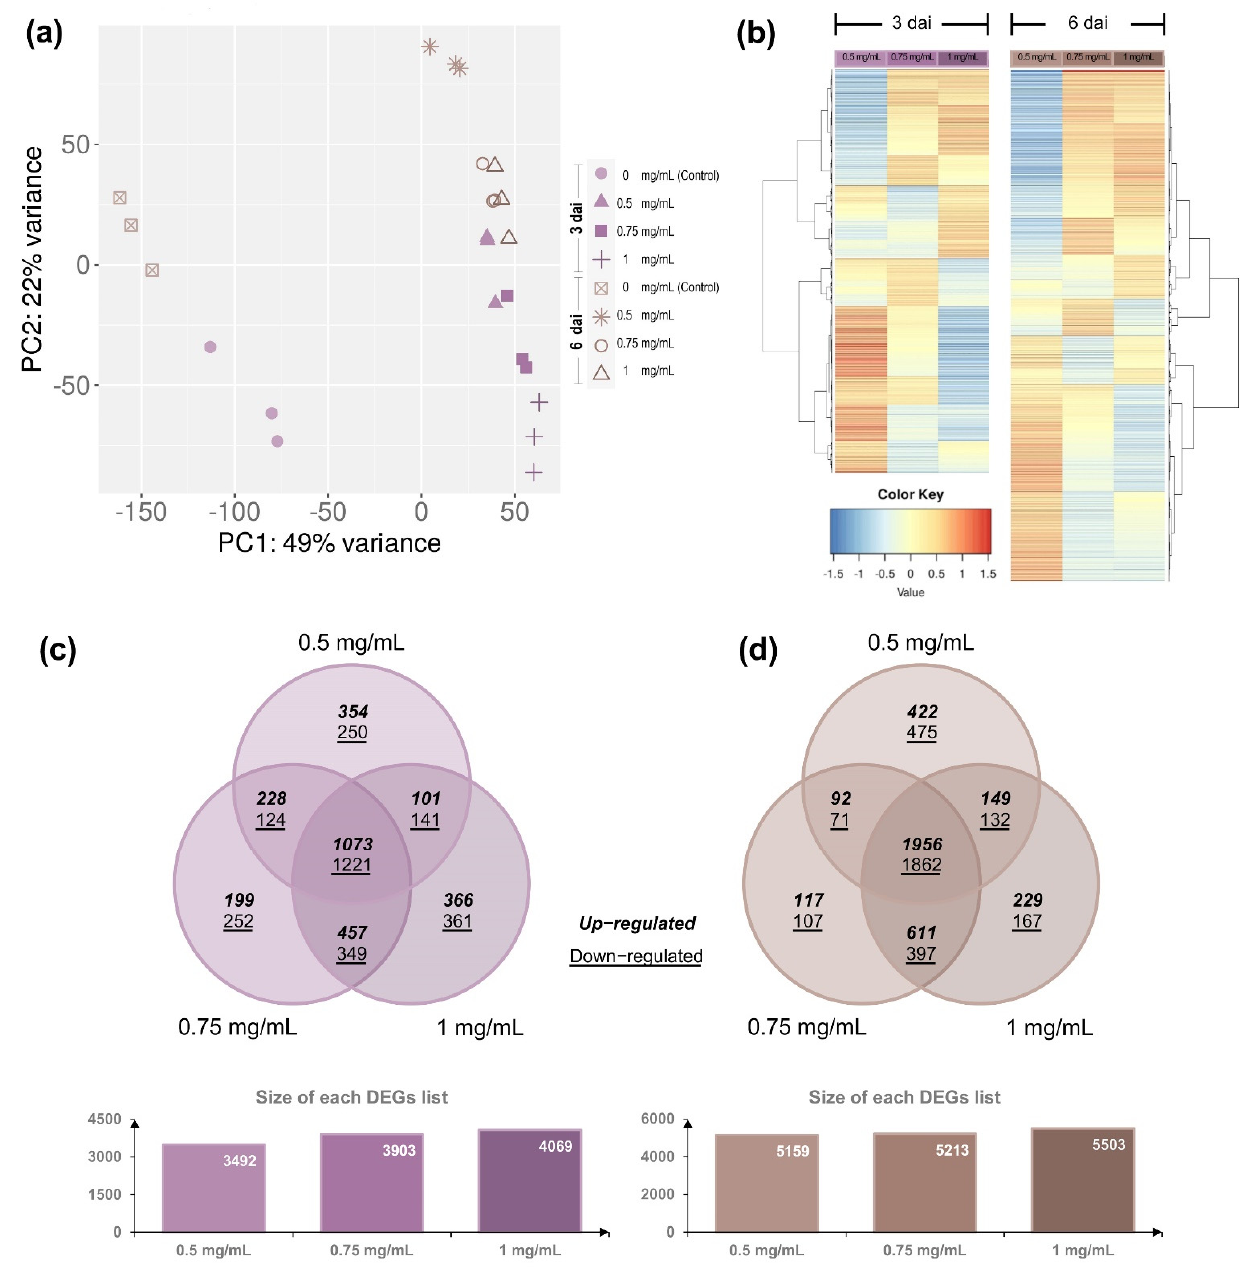
Figure 4. Expression profiles of Fusarium kuroshium Differentially Expressed Genes (DEGs) in response to Cu-NPs. ( a ) Principal component analysis (PCA) plot displaying all 24 RNA-seq sequenced libraries used in the presented study, the three independent replicates of the distinct concentrations of Cu-NPs used (0 (control), 0.5, 0.75 and 1 mg/mL) and evaluated at 3 and 6 days after inoculation (dai). PCA was performed using the transcripts per million (TPM) values. ( b ) Heatmaps of the average linkage hierarchical clustering based on the correlation distance measurements. Log 2 FC values ( ± 1) that resulted in significance (adjusted p value of ≤ 0.05) were used to represent the lists of DEGs obtained from both the 3 and 6 dai. DEGs lists were generated from pairwise comparisons in which each of the Cu-NPs treatments (0.5, 0.75, and 1 mg/mL) were compared against the control sample (0 mg/mL). The Venn diagram represents the shared amount of up- and downregulated genes in each Cu-NPs treatment at the two sampling points evaluated, 3 dai ( c ) and six dai ( d ).